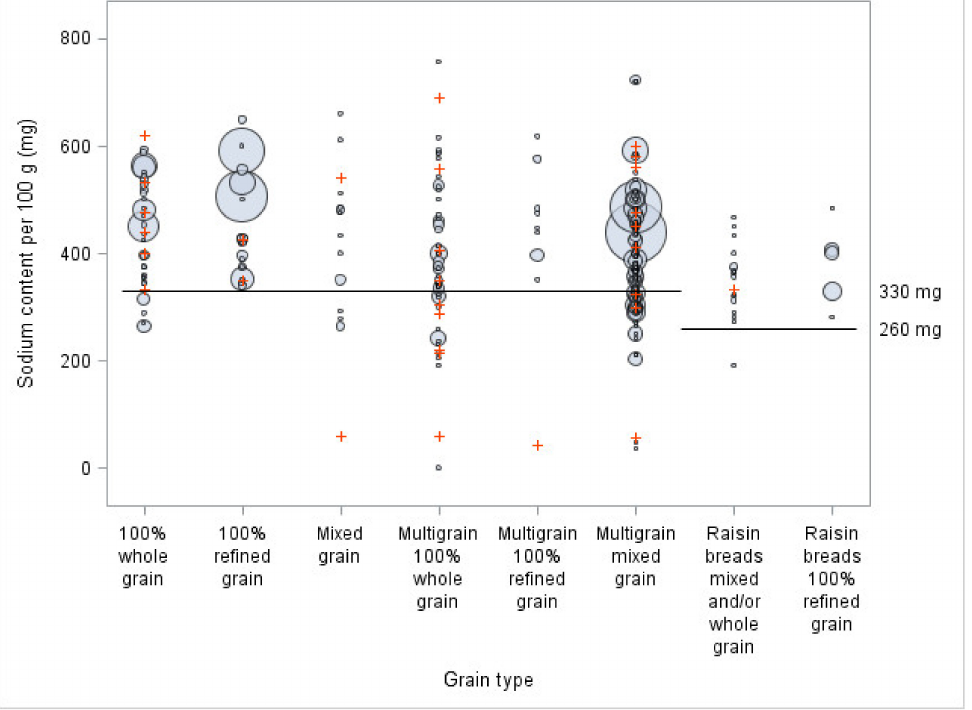
Figure 2. Sodium content per 100 g of different breads, by type of grain and sales volume ( n = 294), compared to Health Canada final voluntary sodium reduction targets. The bigger the circles, the higher the sales. Signs + represent sliced bread for which sales data were not available. A portion of 50 g was used when the weight of two slices was inferior to 50